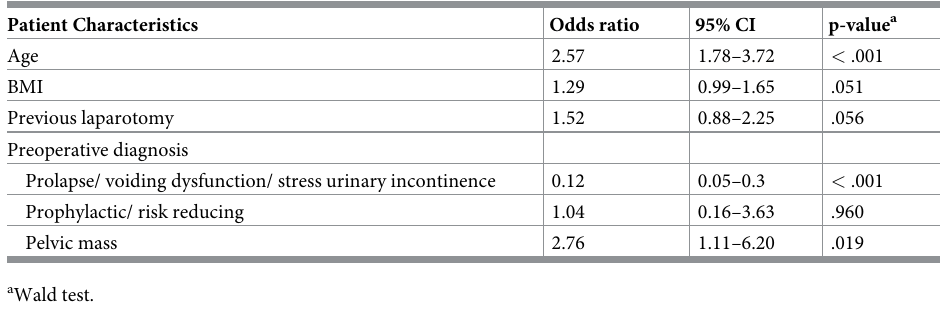
Table 4. Logistic regression model between patient characteristics and